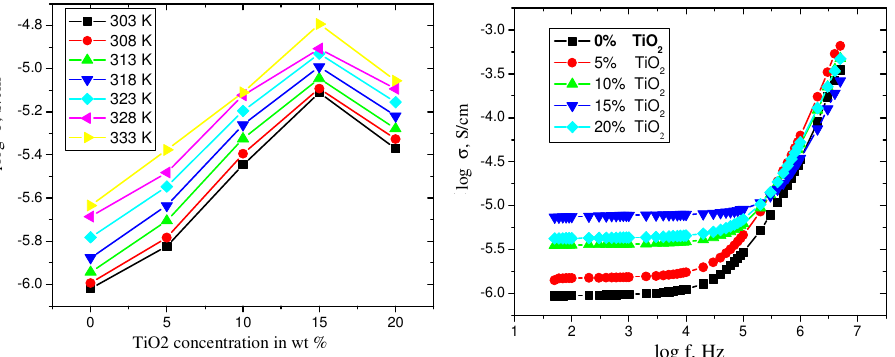
log f, Figure 5. Variation of conductivity with frequency for all the samples at 303K